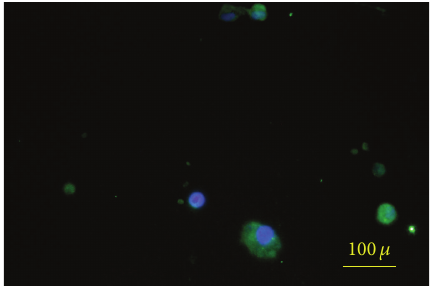
Figure 7: Neural stem cell stained with CD133 and DAPI.